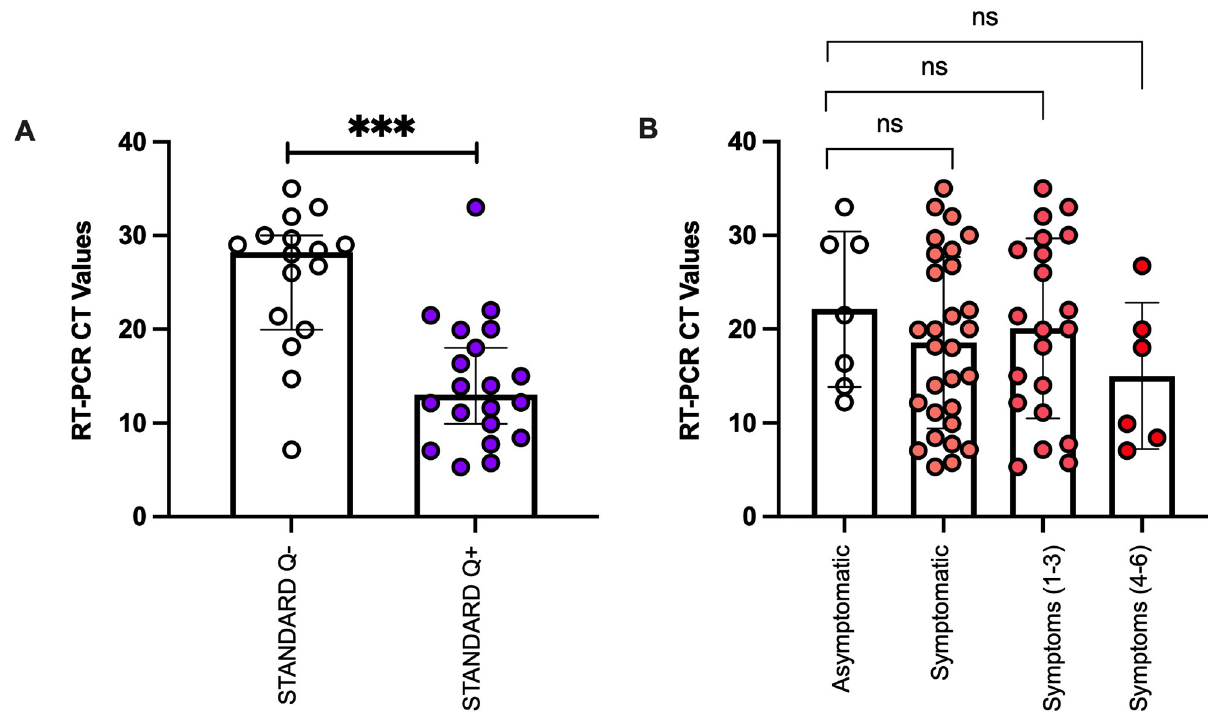
Fig 2. CT values in participants who tested positive for SARS CoV-2 by RT-PCR. (A) Participants grouped according to the STANDARD Q results ( ��� p = 0.0001). (B) Participants were grouped as asymptomatic, all symptomatic, having 1 to 3 symptoms and having 4 to 6 symptoms. P-value was not significant